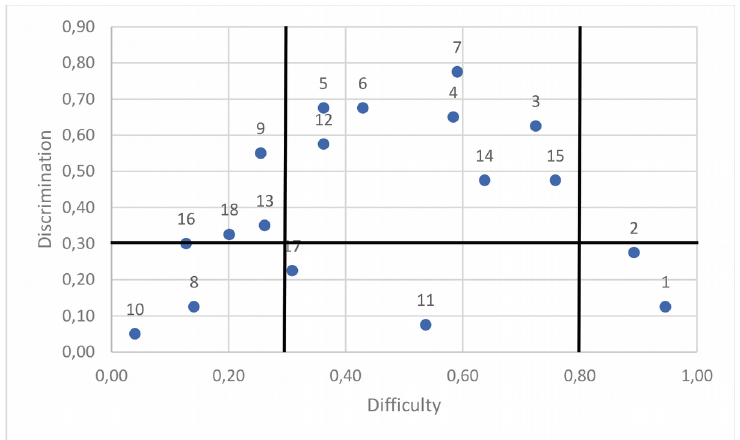
Figure 3. Difficulty and discrimination indices for each of the 18